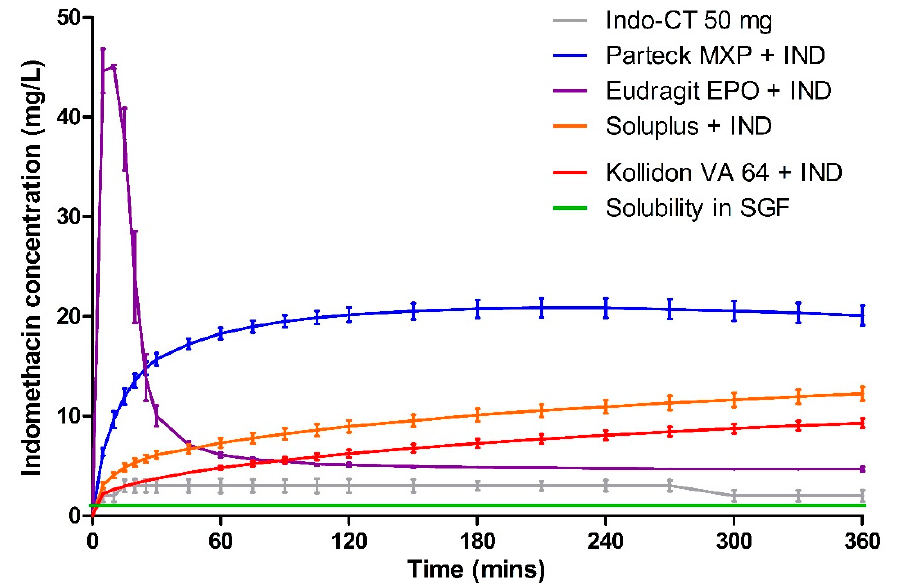
Figure 7. Dissolution testing for milled VCM material in simulated gastric fluid.